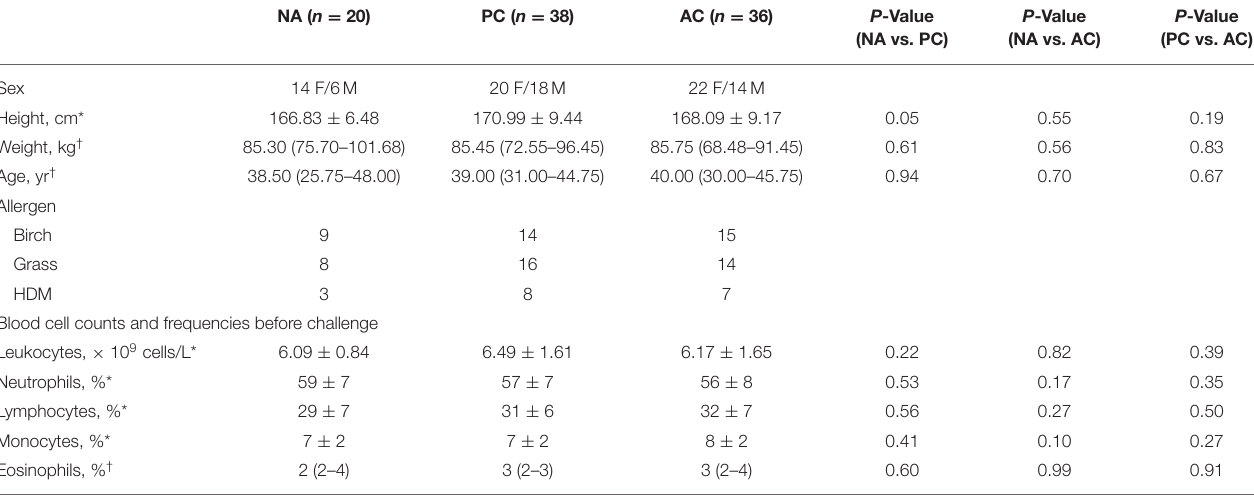
TABLE 1 | Demographics of research